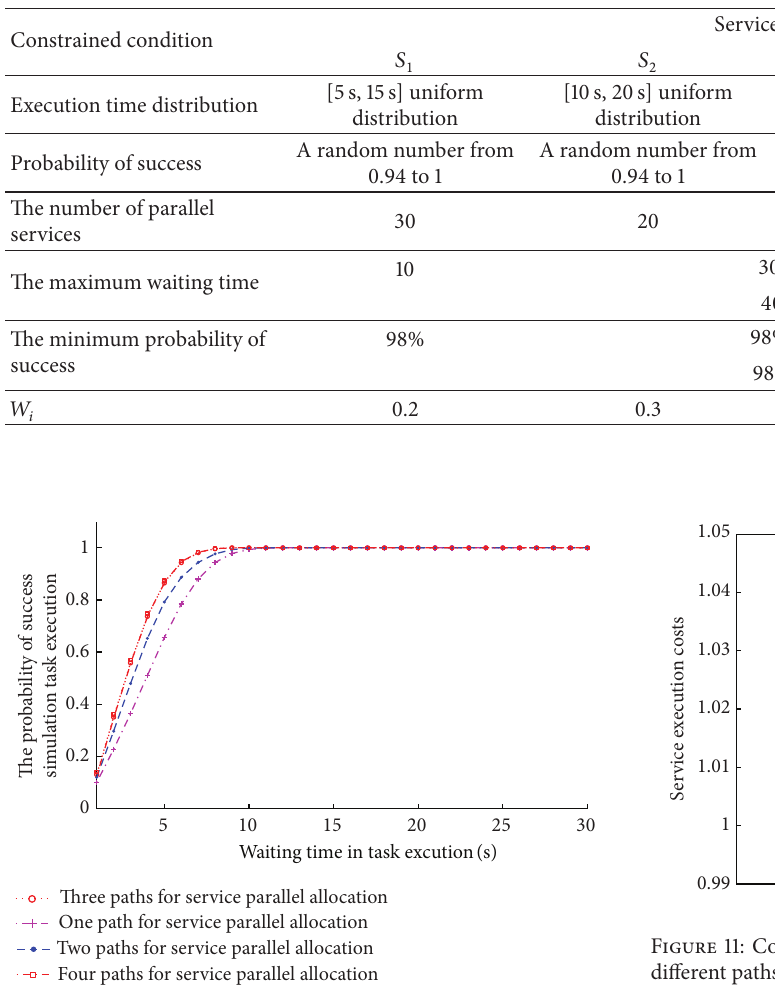
Figure 10: Comparison of the effect for the probability of success simulation task with different paths.